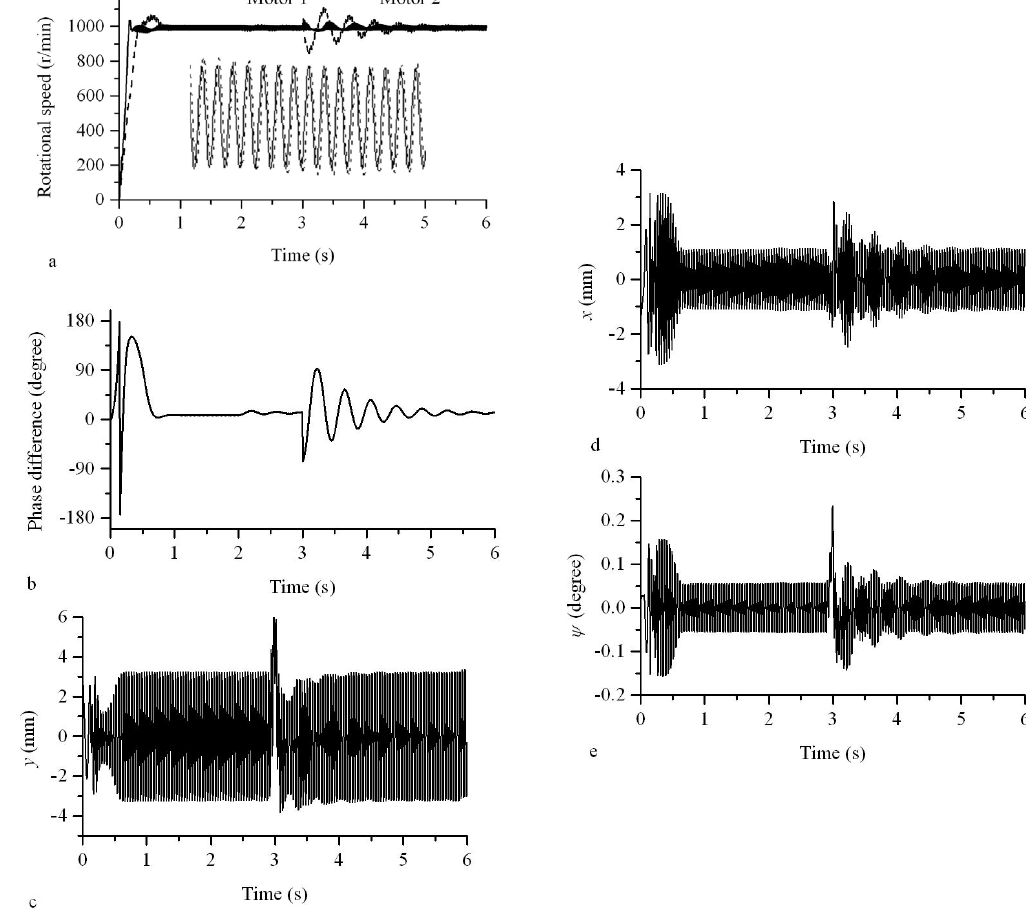
Fig. 3. Results of computer simulation of a vibrating system with two non-identical